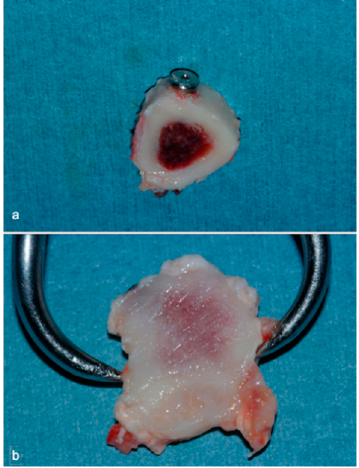
Figure 5. Bone sample including implant ( a , b ).